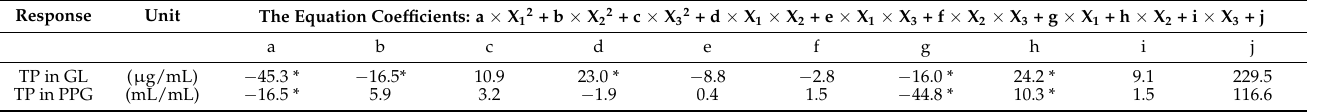
presented in form of response surface plots. Table 3. Polynomial equations for the total phenolic content (TP) in glycerol (GL) and polypropyleneglycol (PPG) extraction